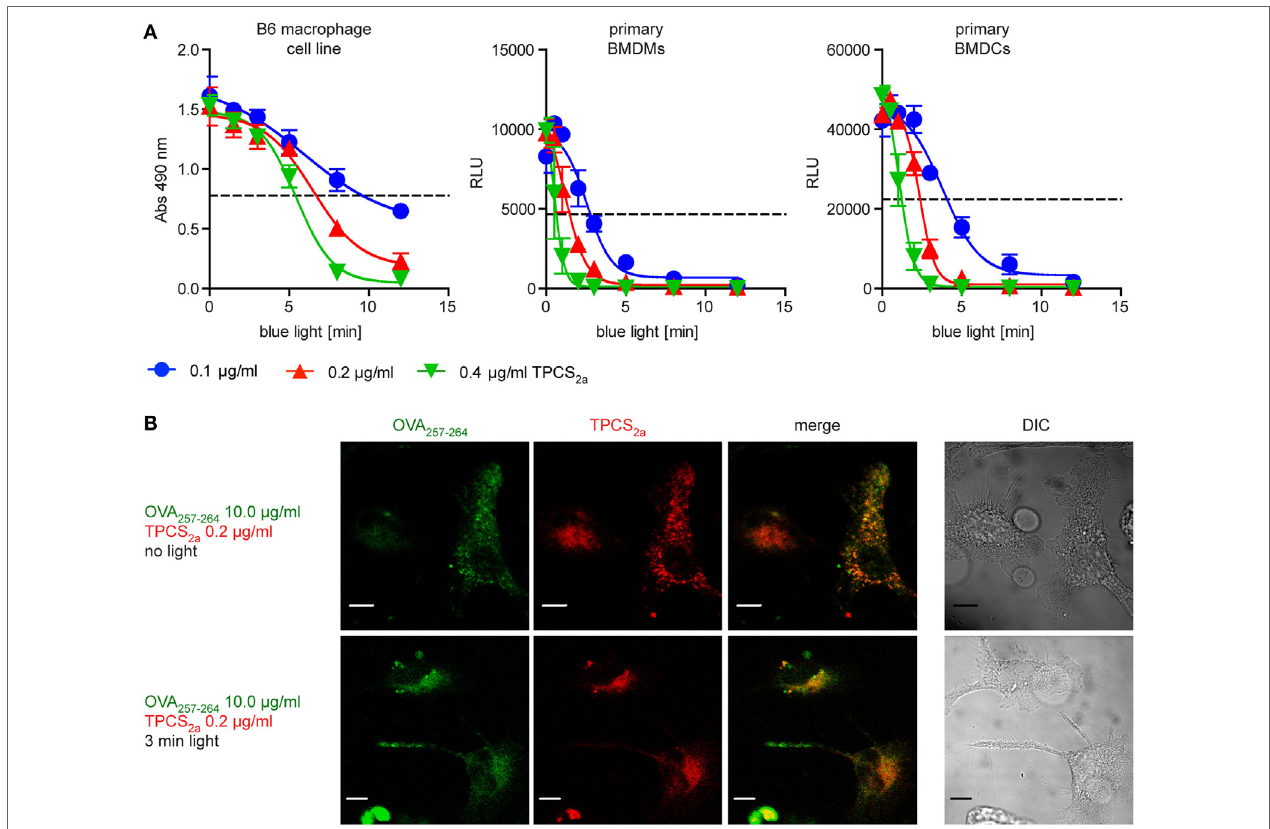
FigUre 1 | Photochemical internalization (PCI) treatment routes endocytosed peptide antigens to the cytosol of antigen-presenting cells (APCs), though the treatment has a dose-dependent cytotoxic effect. (a) Analysis of the effect of PCI treatment on the viability of APCs. Immortalized B6 mouse macrophages (left) as well as primary bone marrow-derived macrophages (BMDMs) (middle) and primary bone marrow-derived dendritic cells (BMDCs) (right) were incubated for 18 h with 0.1 (blue), 0.2 (red), or 0.4 µg/ml (green) of the photosensitizer TPCS 2a . Cells were illuminated for 0–12 min and viability was assessed 18 h post illumination. The metabolic activity of the B6 cell line was analyzed by an MTT assay ( y -axis = absorption at 490 nm). Viability of primary BMDMs and primary BMDCs were analyzed by measurement of ATP content in a luminescence assay ( y -axis = relative light units). The dotted line indicates approximately 50% cell viability. Three or more experiments with comparable results were performed for each cell type, shown is one representative experiment. (B) Effect of PCI treatment on the intracellular localization of the photosensitizer TPCS 2a and OVA 257–264 peptide antigen. Immortalized mouse macrophages were incubated in the dark for 18 h with 0.2 µg/ml of the photosensitizer TPCS 2a . After washing, cells were incubated for additional 4 h with 10 µg/ml 5-Carboxyfluorescein labeled OVA 257–264 in TPCS 2a -free medium. The cellular distribution of fluorescence from OVA 257–264 (red) and TPCS 2a (green) was analyzed by confocal microscopy without photo-activation (upper panels) or directly after 3 min blue light illumination (lower panels). Scale bars represent 5